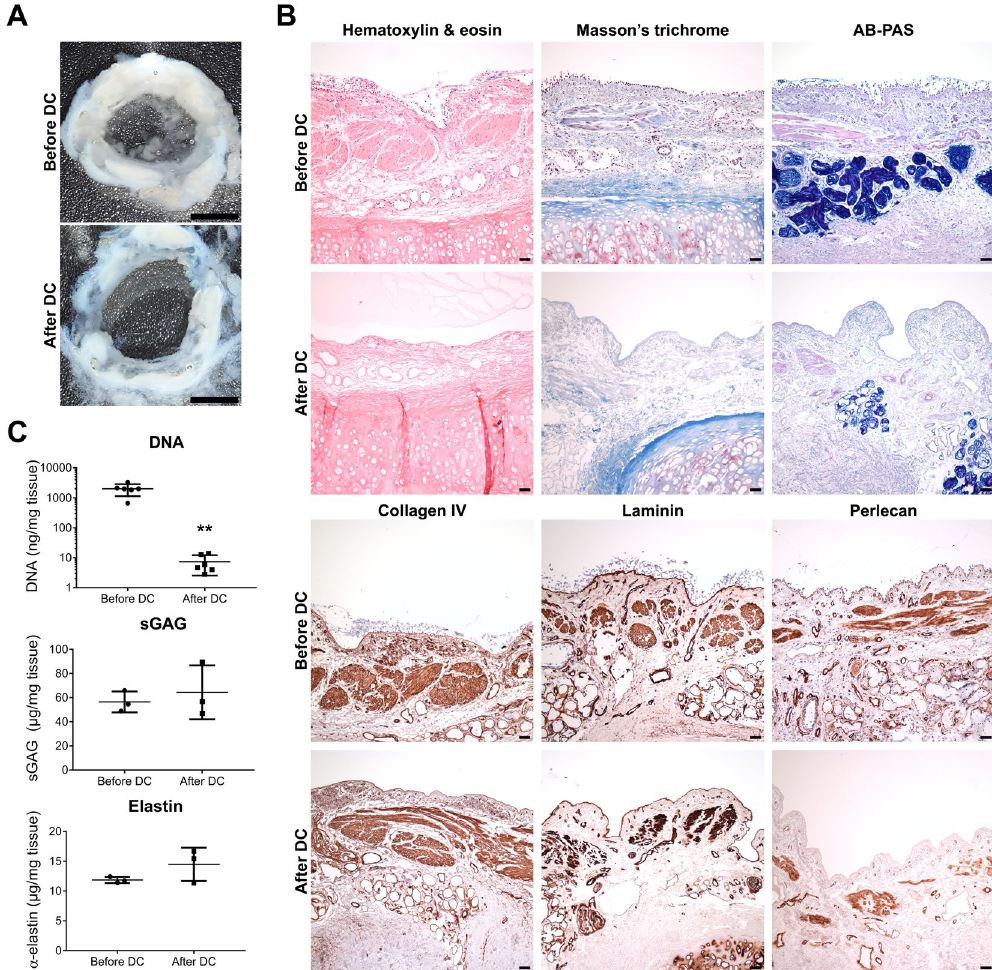
Figure 2. Decellularization of human bronchial airways efficiently removes cells while preserving the extracellular matrix. ( A) The macroscopic structure of the 500 µ m thick human bronchial tissue sections was preserved after decellularization (DC). (B) Hematoxylin & eosin, Masson’s trichrome (collagen in blue) and alcian-blue periodic acid Schiff (AB-PAS) (polysaccharides in magenta/purple) stainings as well as immunohistochemistry against the basement membrane proteins collagen IV, laminin and perlecan, before and after DC. Images are representative of n = 3. (C) Dye-binding methods confirmed that DC efficiently decreased DNA content ( ** p = 0.002) while preserving sulfated glycosaminoglycans (sGAG) and elastin in bronchial scaffolds (n = 6 for DNA, n = 3 for sGAG and elastin). The data were analyzed with the Mann-Whitney test and graphs indicate mean and standard deviation. Scale bars: 3 mm in A and 50 µ m in